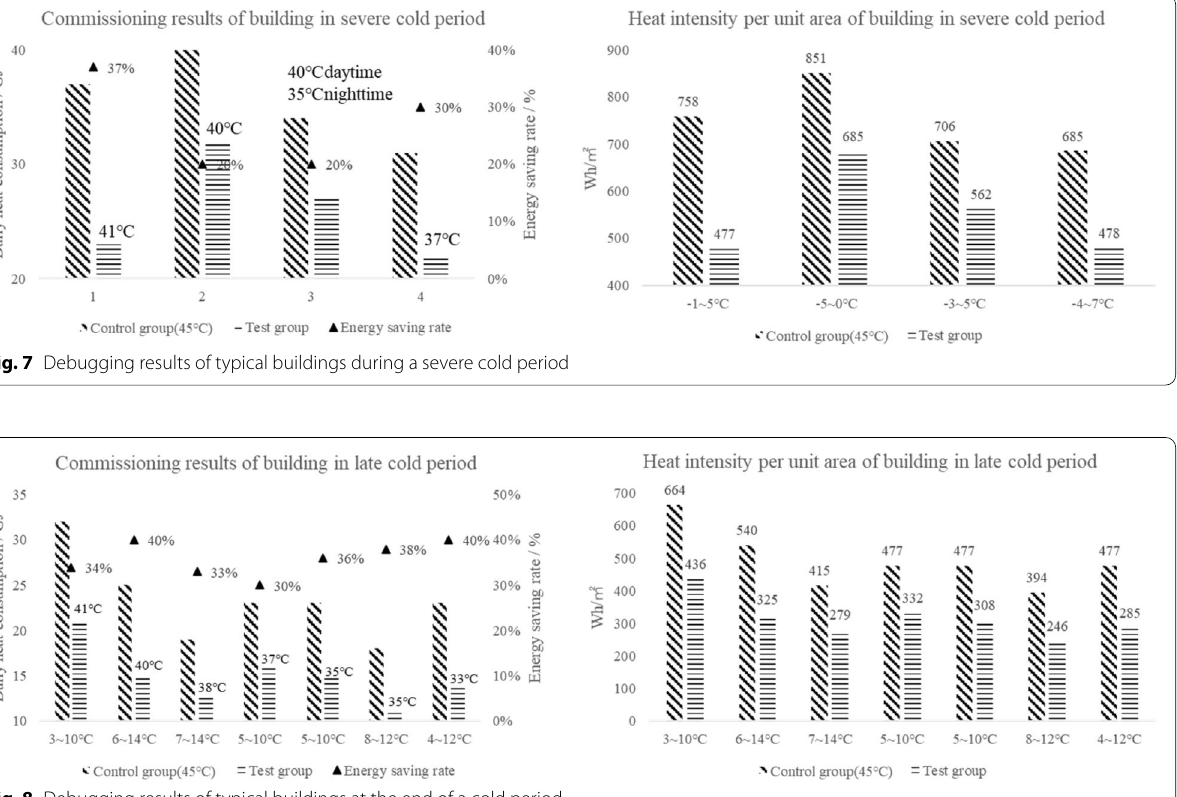
Fig. 8 Debugging results of typical buildings at the end of a cold